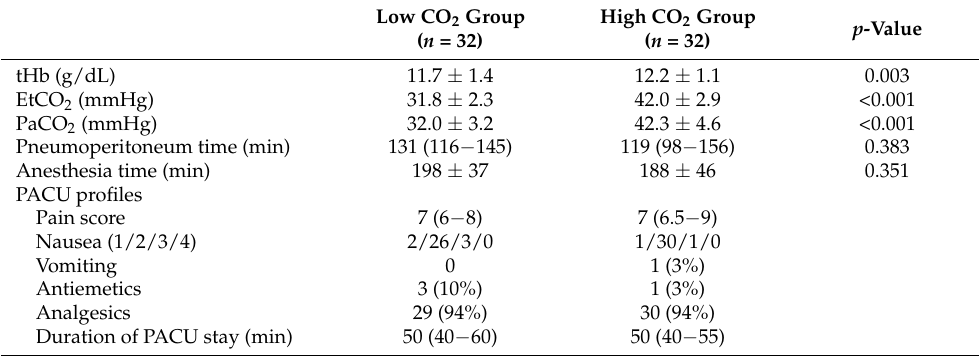
Figure 3. Bland — Altman’s plot showing repeated measurements in the low carbon dioxide (CO 2 ) ( a ) and high CO 2 groups ( b ). The four-quadrant plot of Δ SpHb and Δ tHb is shown in Figure 4. The low CO 2 group showed a highly acceptable concordance rate of 95.9% (47 of 49) and a moderate positive